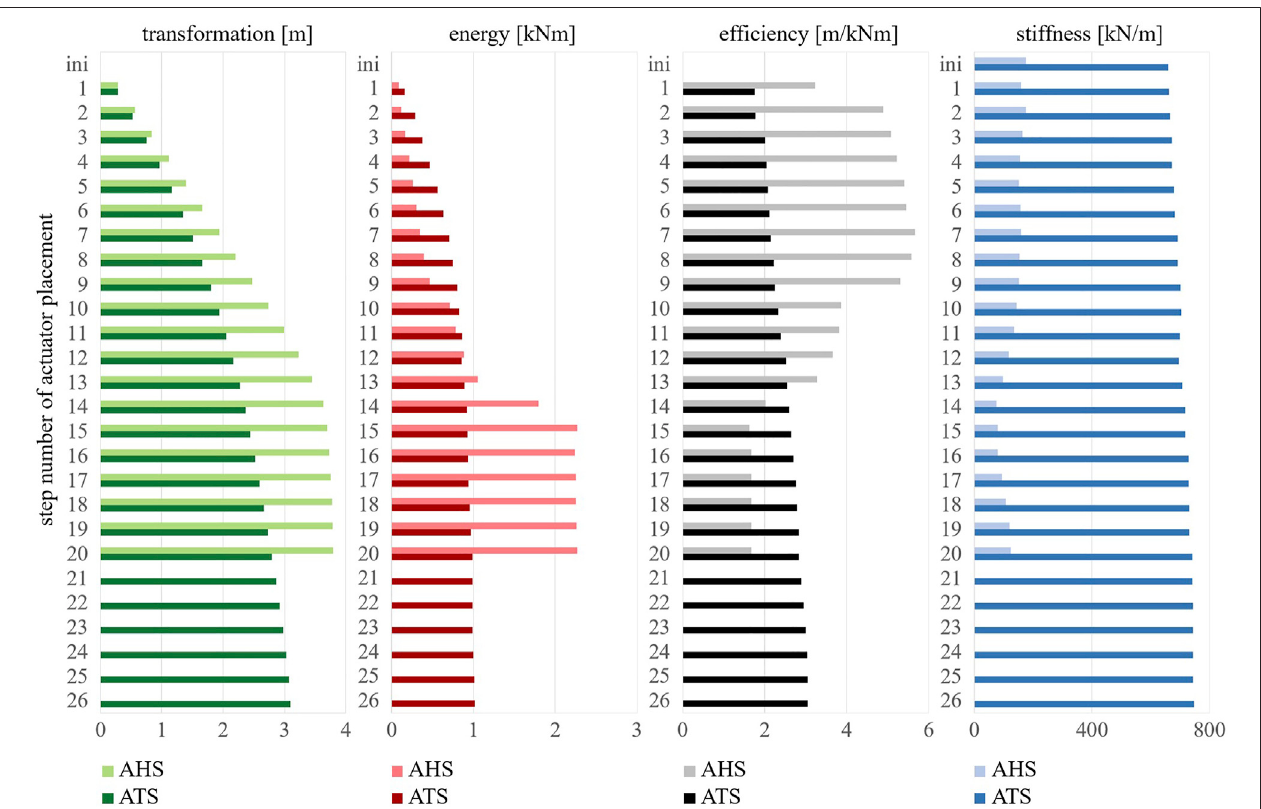
FIGURE 12 | Bar chart comparison of result values of stepwise heuristic actuator placement with operator χ for active truss structure (ATS) ( Figure 6E ) (dark bar charts)vsforactivehybridstructure(AHS)( Figure8E )(lightbarcharts);forcriteriavalues,transformation(green)( Eq.12 ),energy(red)( Eq.13 ),ef fi ciency(black)( Eq.18 ), and stiffness (blue) ( Eq. 5